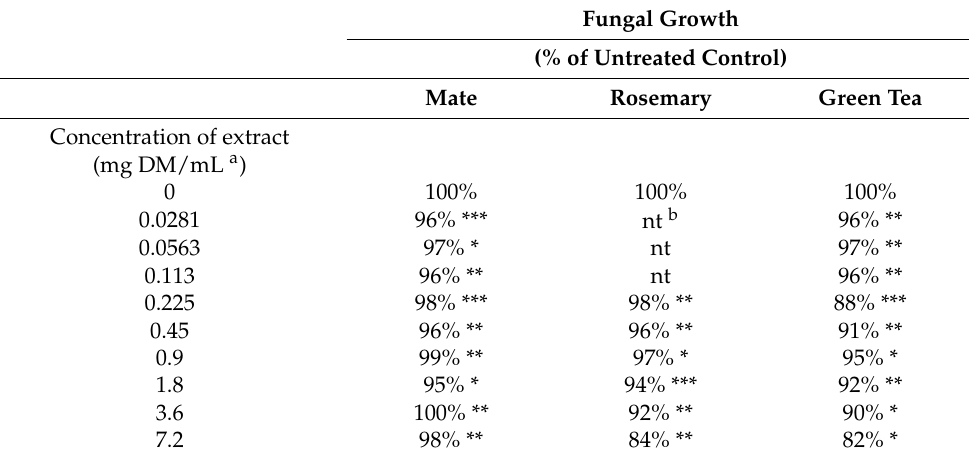
Table 1. Impact of plant extract concentration on growth of A. flavus as measured by colony diameter after 7 days of culture at 27 ◦ C. Fungal Growth (% of Untreated Control) Mate Rosemary Green Tea Concentration of extract (mg DM/mL a